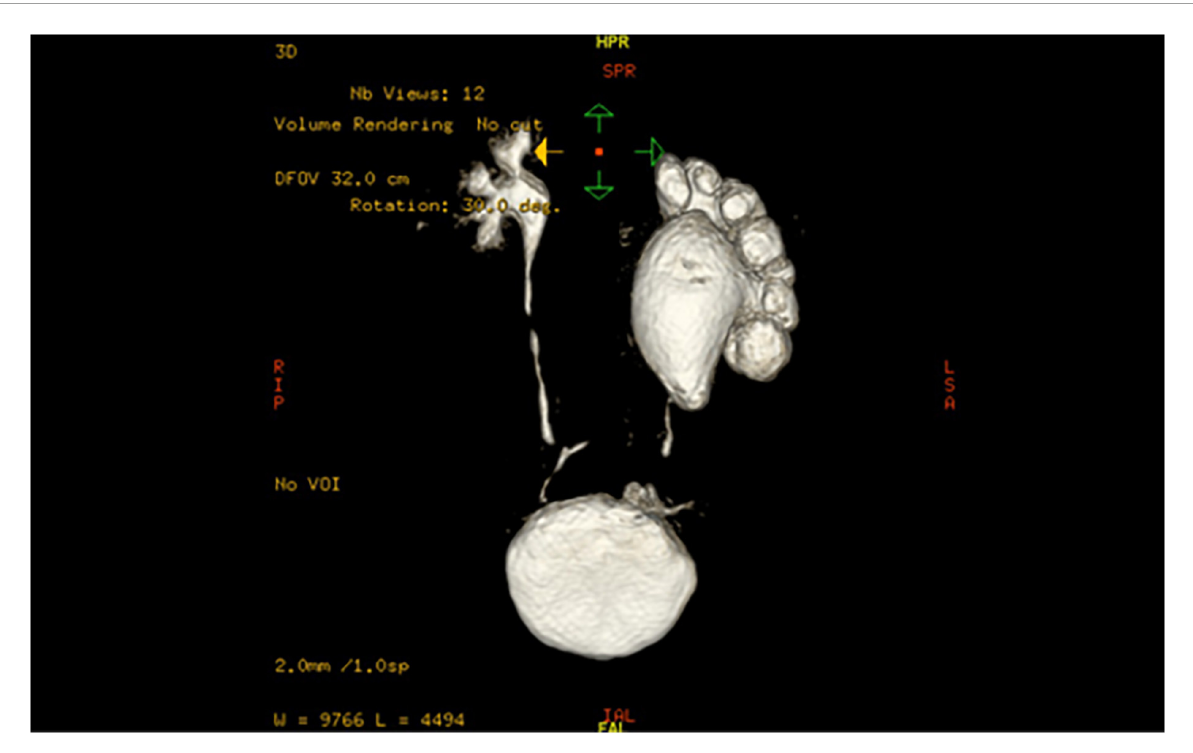
FIGURE1 Magnetic resonance urography (MRU) results of the patients.